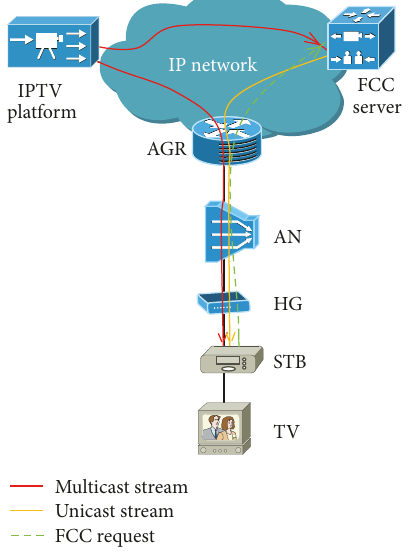
Figure 3: Working principle of FCC.